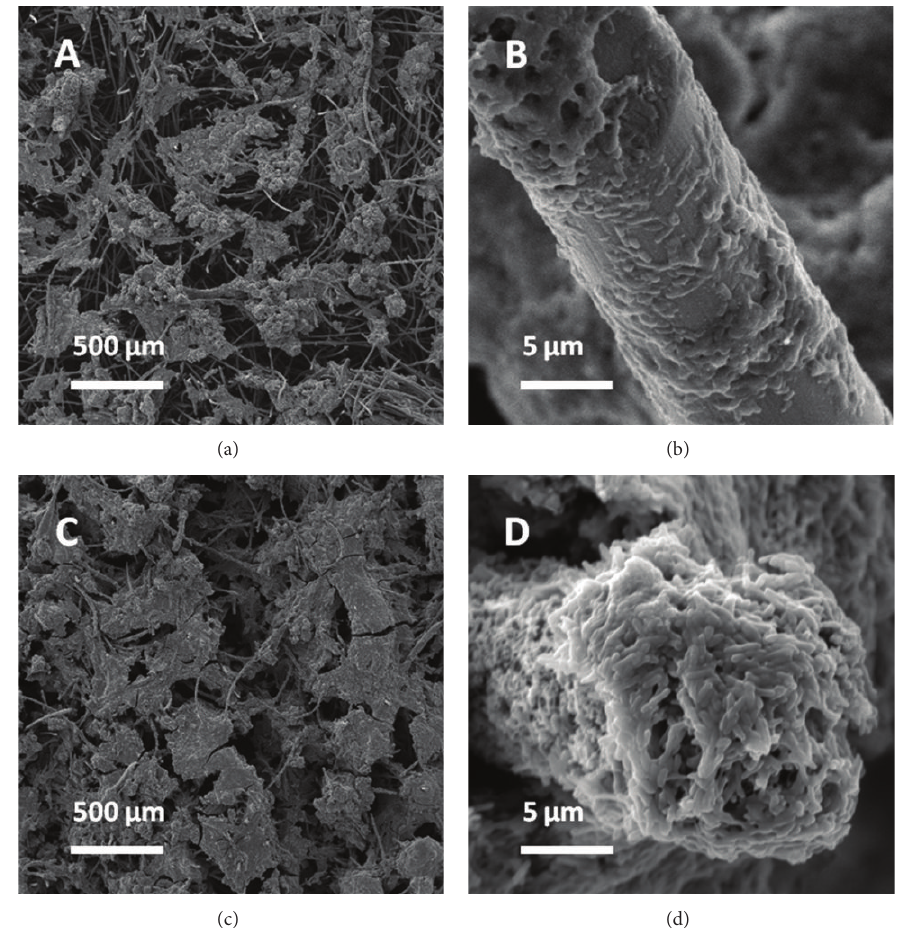
Figure 3: Overview and detailed SEM images of ((a) and (b)) biofilms in GF and ((c) and (d))